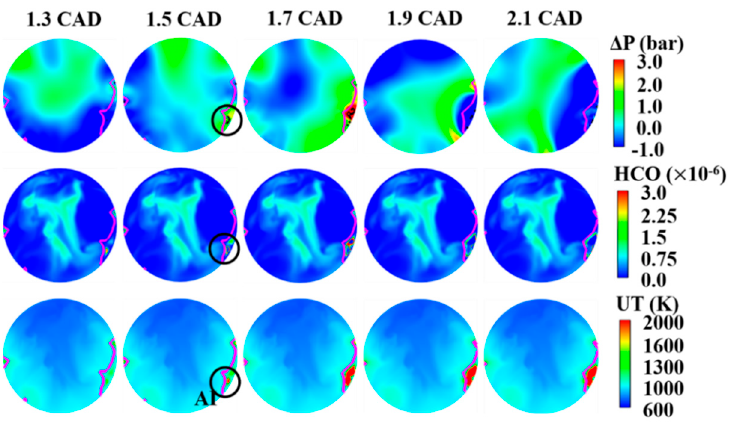
Figure 21. Evolution of ∆ P, mass fraction of HCO, and unburned temperature after the initial auto-ignition at u / u 0 = 4.0.